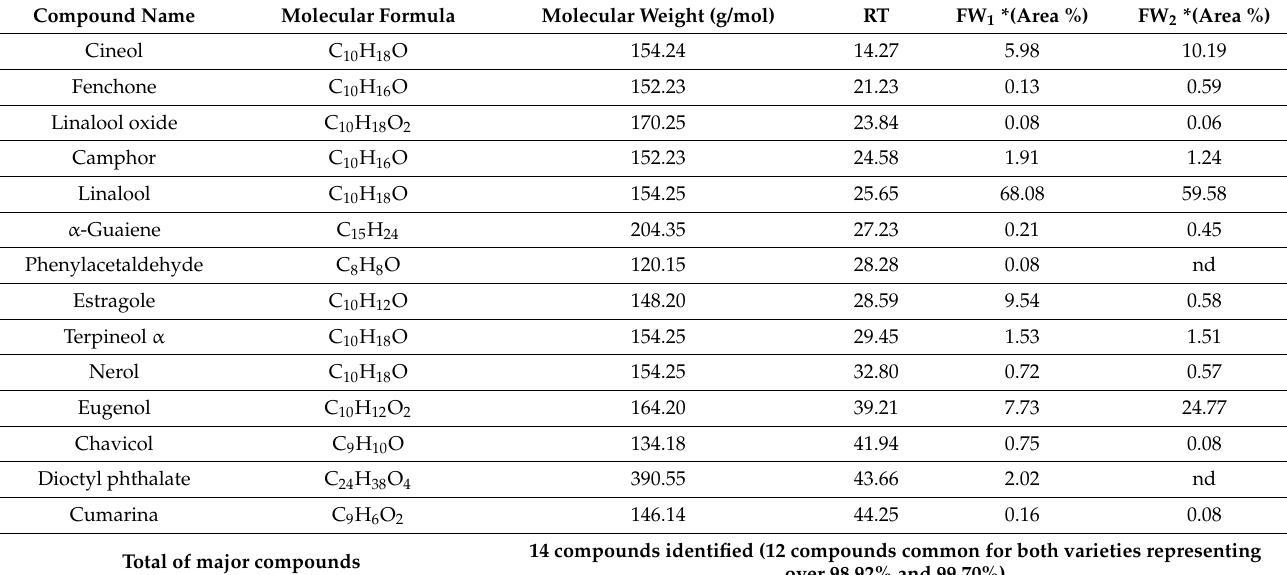
Table 3. Chemical composition of the FWs isolated from aerial part of the basil ( Ocimum basilicum L., fam. Lamiaceae